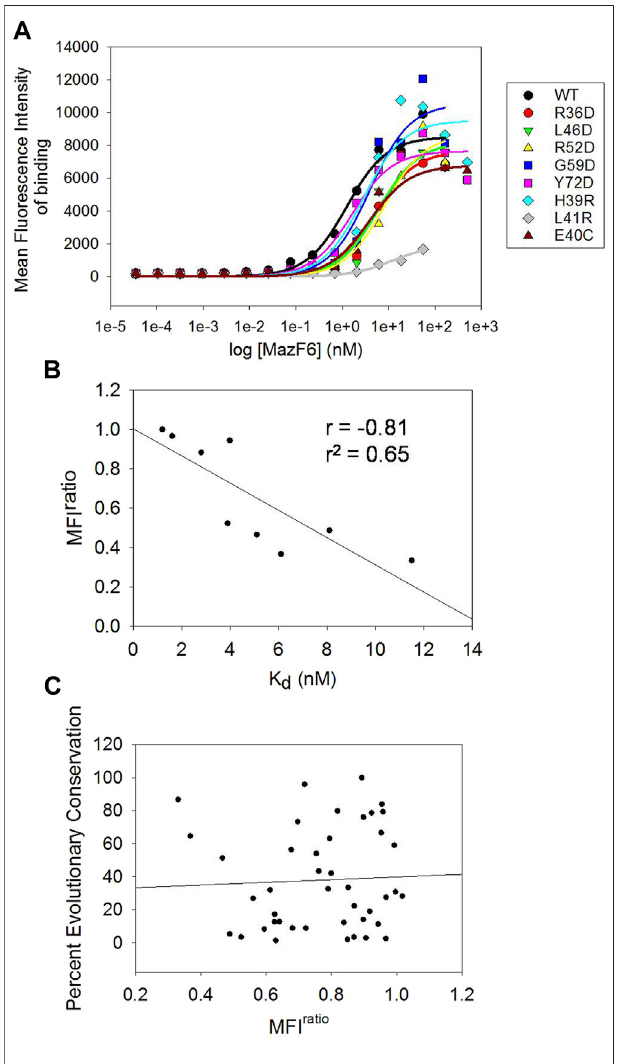
FIGURE 5 | Experimental quanti fi cation of K d of binding, and correlation of evolutionary conservation with mutational effects (A) Mean Fluorescence Intensity (MFI) of toxin binding as a function of MazF6 concentration (nM) experimentally recorded for MazE6 WT and eight single mutants. The traces were used to obtain K d values (see Methods). (B) Correlation between the MFI ratio scores from individual FACS analyses of single mutants with the experimentally determined K d values from titration studies. (C) Correlation of MFI ratio scores of aspartate mutants at each position in the 31-82 stretch of MazE6 with the respective percent evolutionary conservation